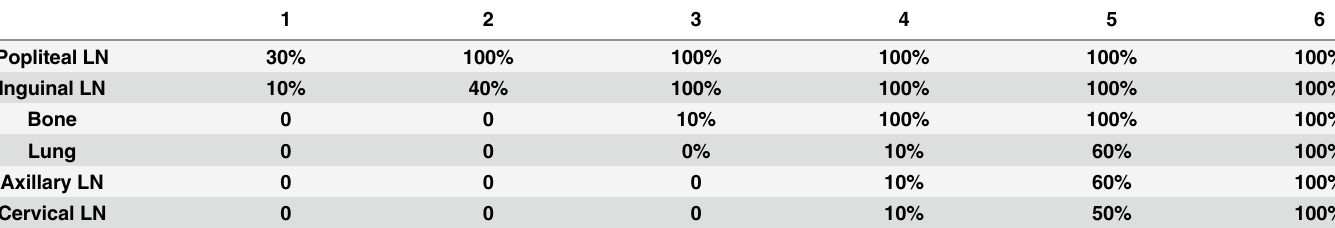
Table 1. Metastatic frequency. Metastasis frequency after in vivo metastasis selection cycles one to six of PC-3-GFP. After 6 cycles of selection, the PC- 3-GFP-LN6 variant subline developed metastasis in the lung, bone, inguinal node, axillary node, and cervical node in all